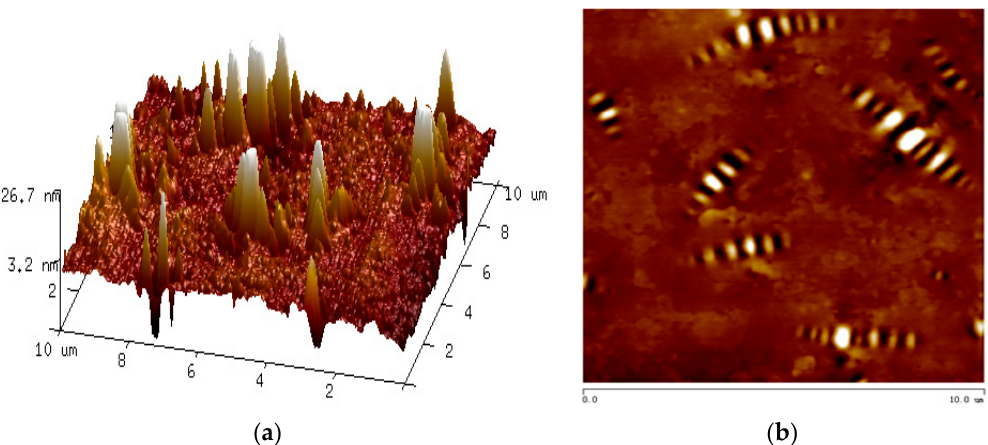
Figure 3 below is an example of the AFM images of bitumen.